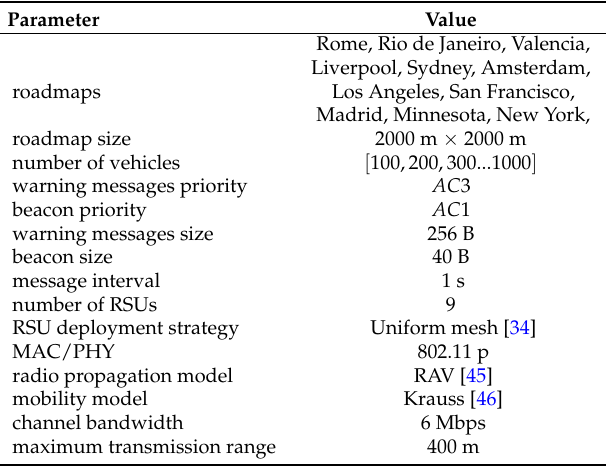
Table 6. Parameters selected for the simulations. AC, access category.